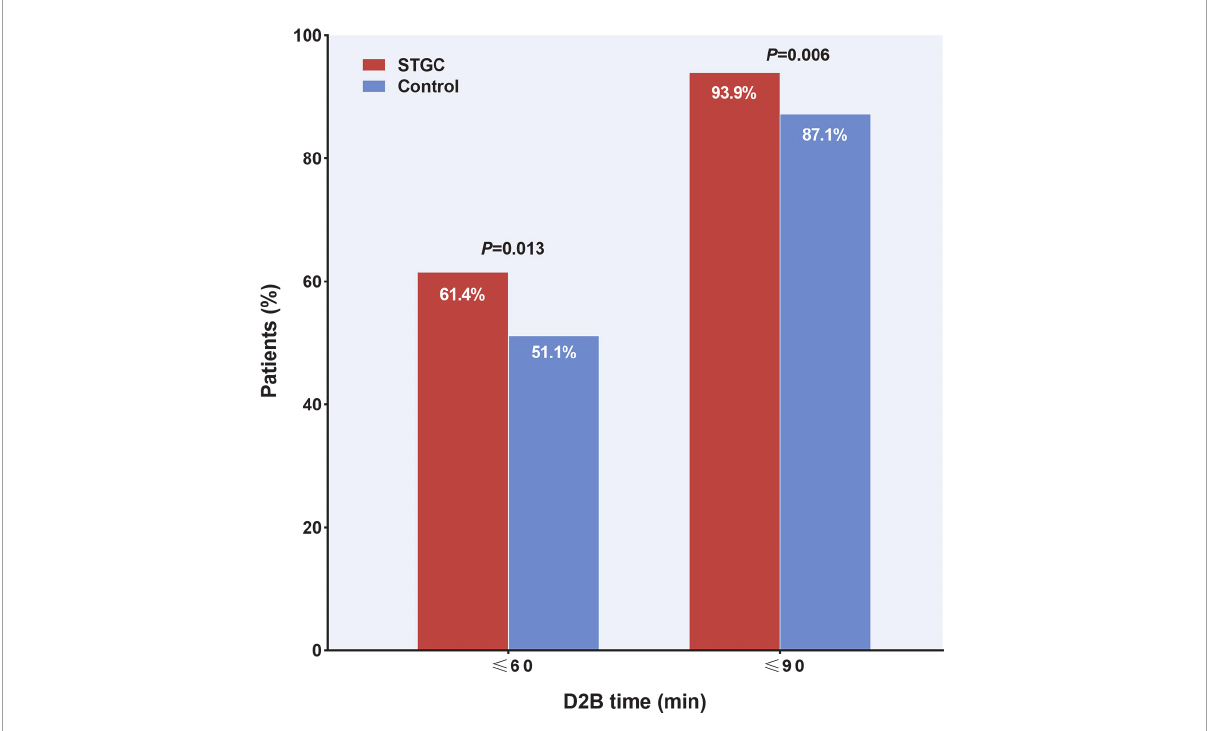
FIGURE3 Proportion of patients achieving door-to-balloon (D2B) target. Proportion of patients with D2B time within 90 and 60 min were significantly higher in the STGC group than in control group ( p = 0.006 and p = 0.013, respectively). D2B, door-to-balloon; STGC, single transradial guiding